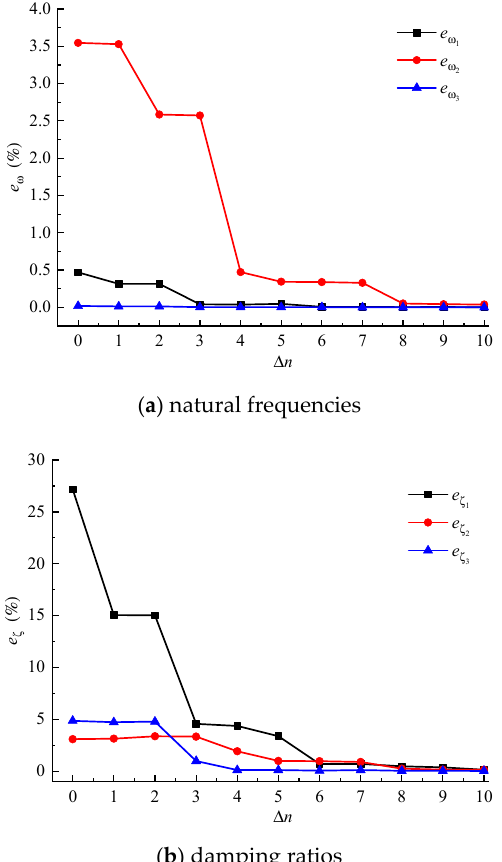
Figure 3. Relative errors of the first three natural frequencies and damping ratios.